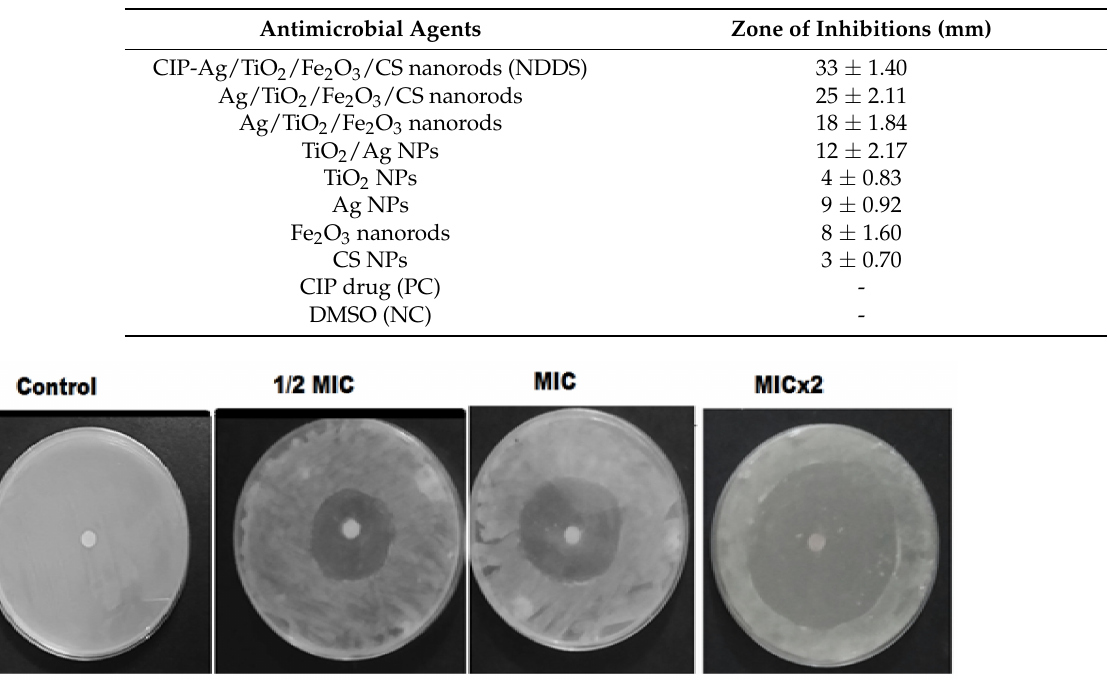
Figure 6. Antimicrobial activity of the green synthesized CIP-Ag/TiO 2 /Fe 2 O 3 /CS nanoformulation (NDDS) at indicated MIC, half of MIC (1/2) and double of MIC (MICx2). DMSO is used as NC (negative